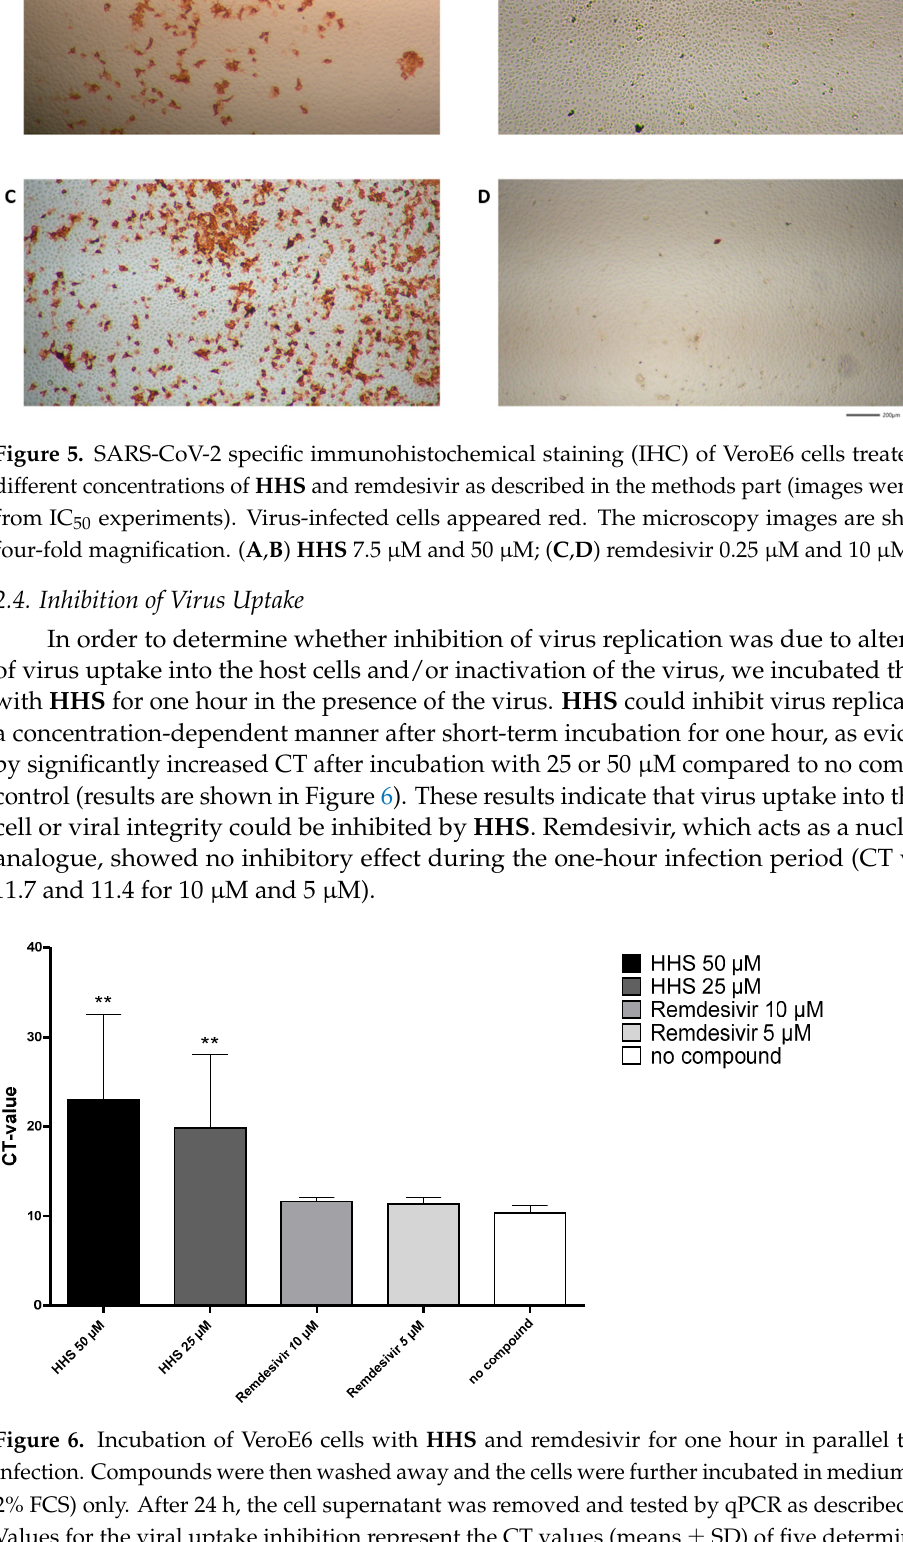
Values for the viral uptake inhibition represent the CT values (means ± SD) of five determinations. Asterisks (**) indicate significantly different ( p < 0.01) in comparison to no compound (Kruskal–Wallis